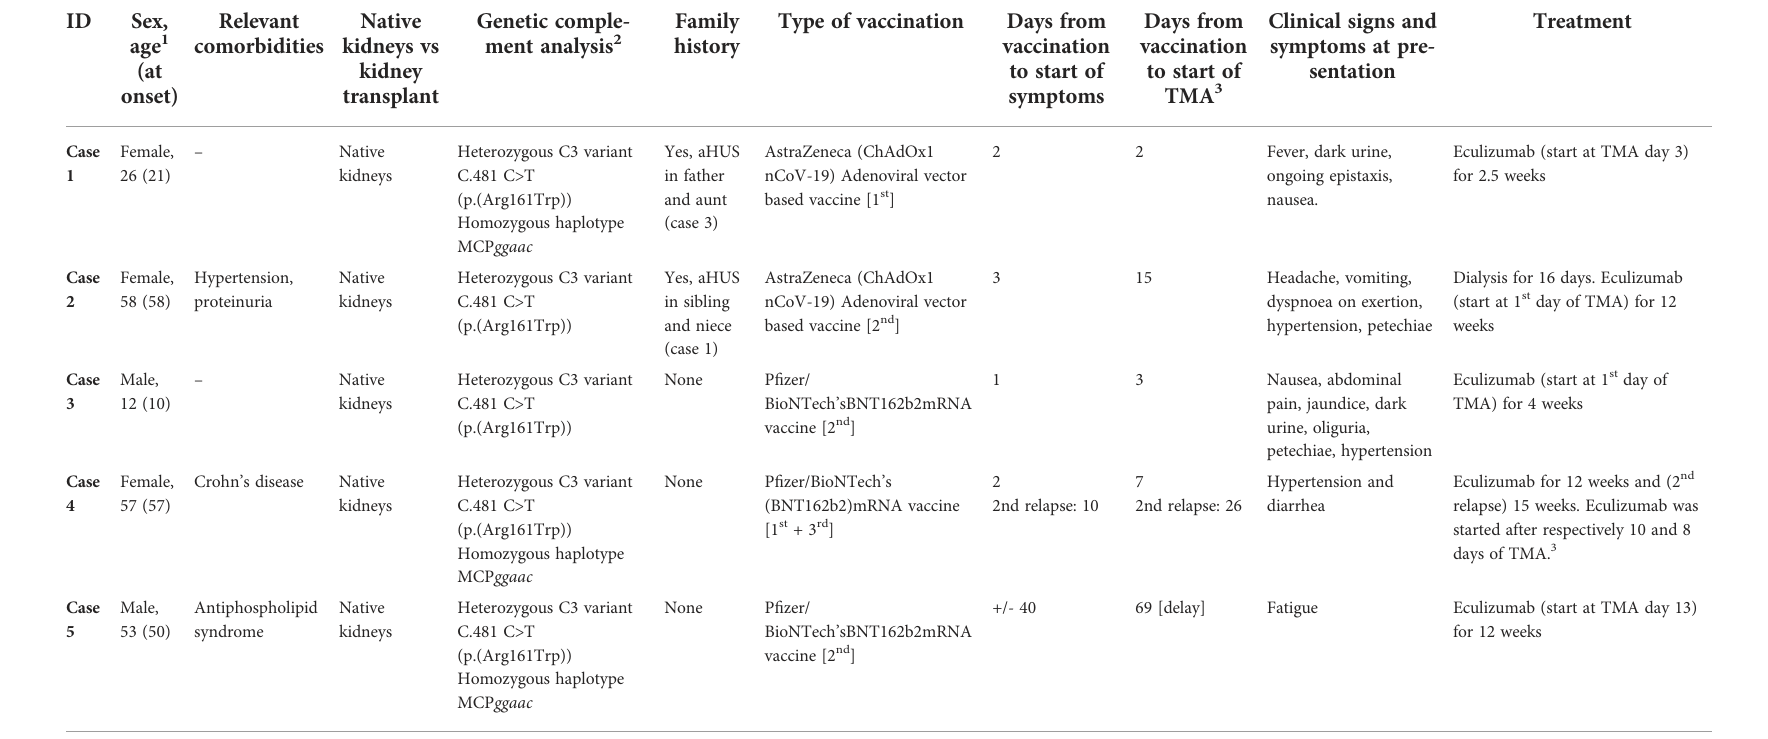
TABLE 1 Patient